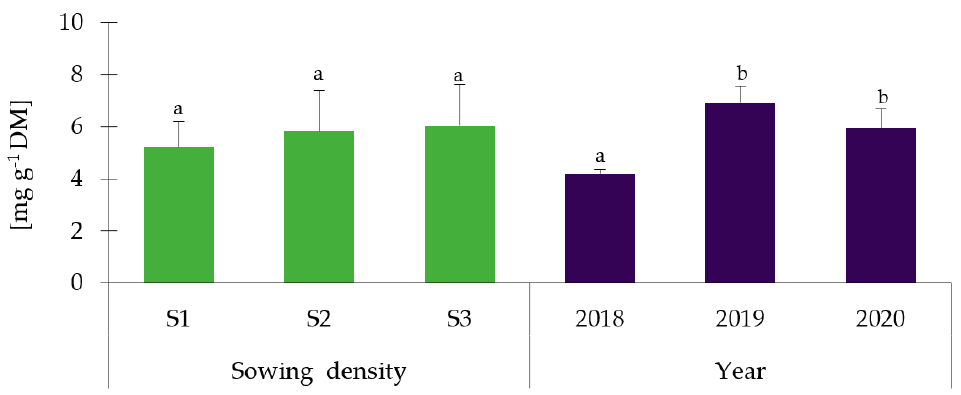
Figure 3. Coumarin content in stems of Melilotus albus . Sowing density: S1—500 pcs·m − 2 , S2—1000 pcs·m − 2 , and S3—1500 pcs·m − 2 . A—before budding, B—budding, C—full flowering. Statistically significant differences ( p < 0.05) according to the three-way analysis of variance (ANOVA) followed by Tukey’s test are marked with different letters.